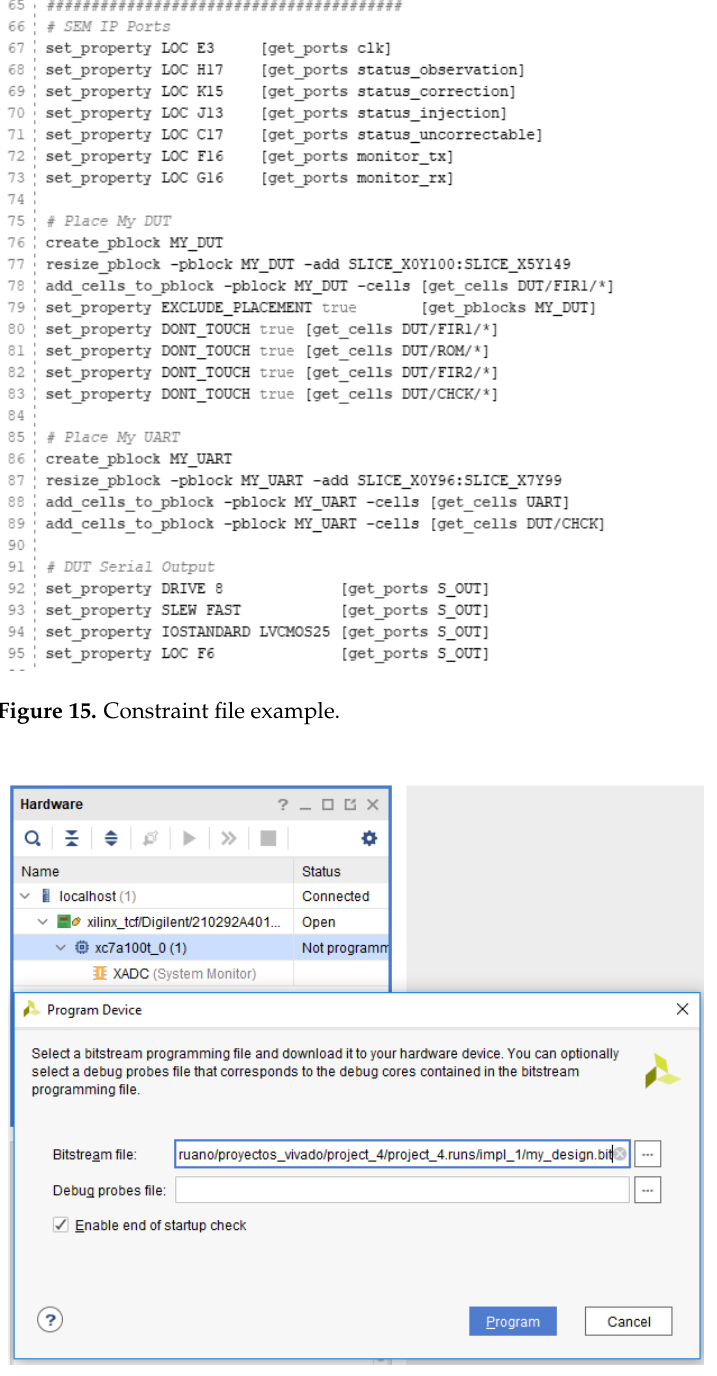
Figure 16. Program SRAM configuration memory.